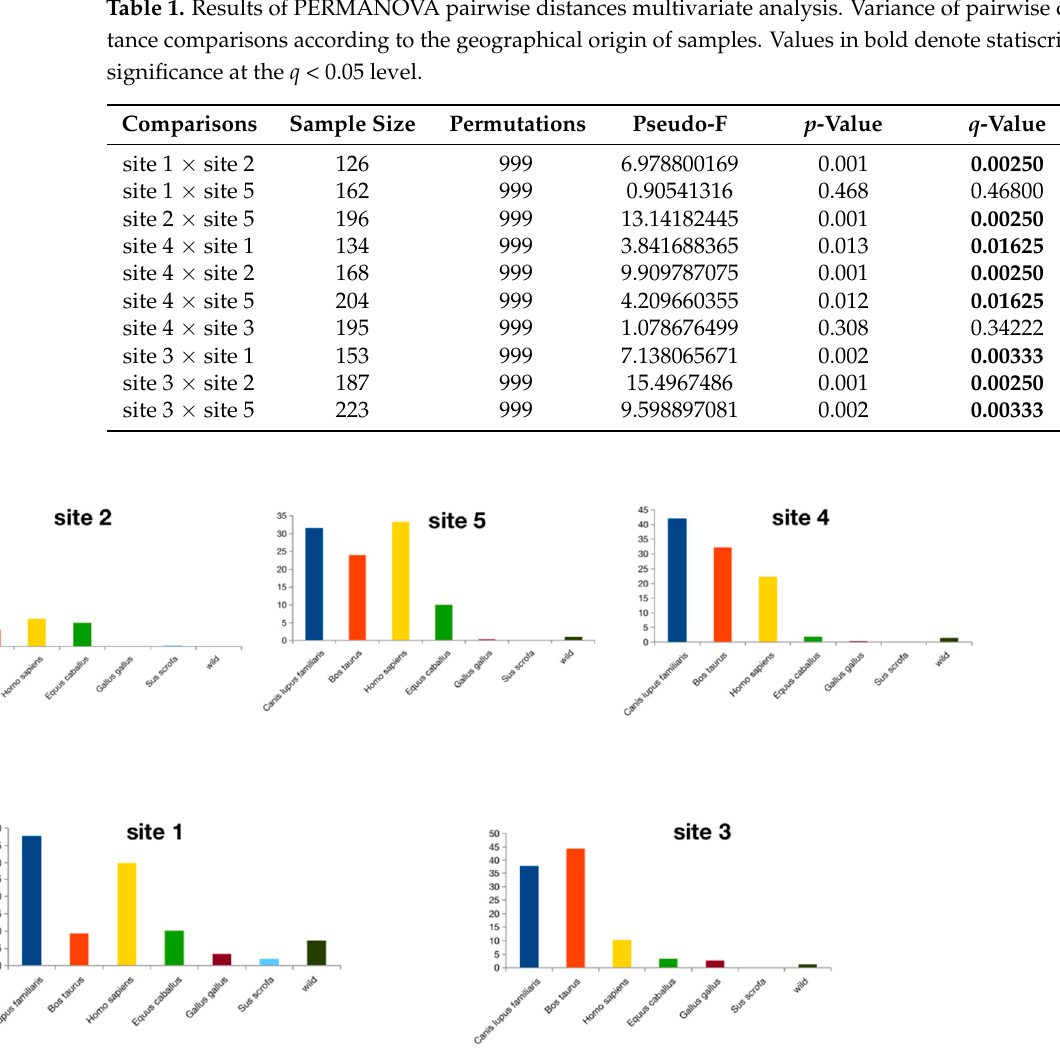
Table 2. Results of PERMANOVA pairwise distances multivariate analysis. Variance of pairwise distance comparisons, according to Mansonia species at each collection point. Values in bold denote statiscrical significance at the q < 0.05 level. Comparisons per Group